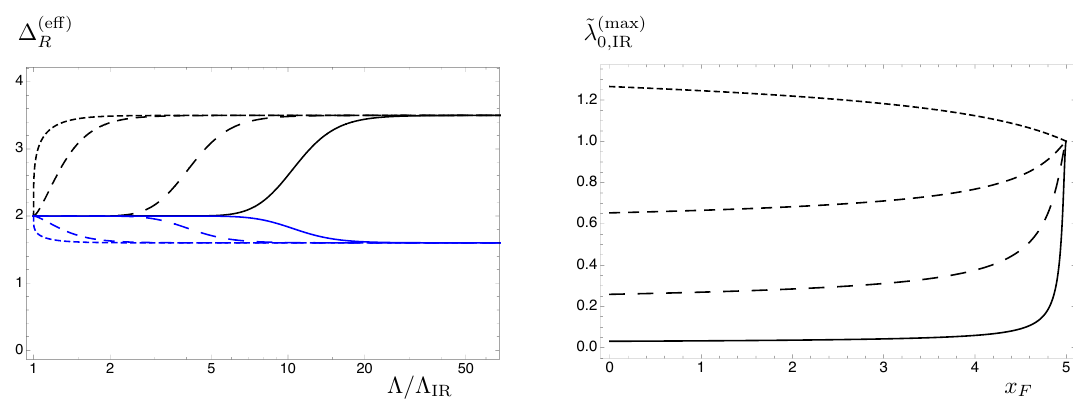
as a function of the R as a 0 , IR